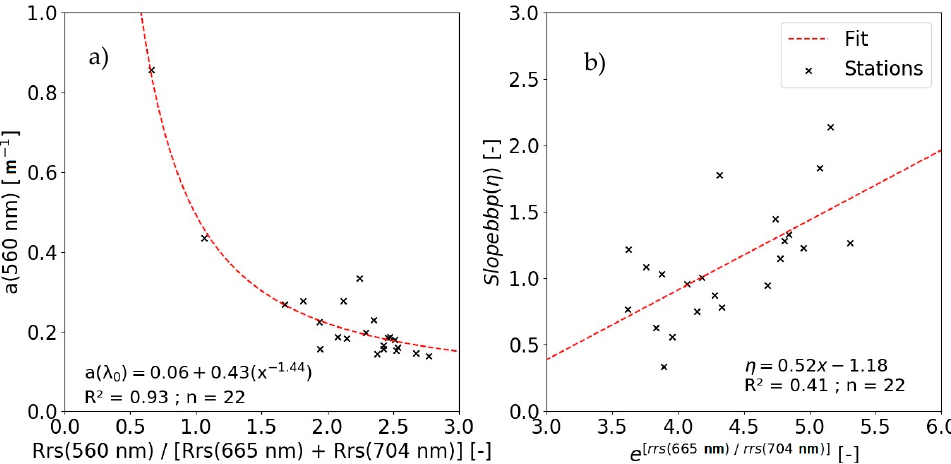
Figure 9. QAA TM reparametrization: ( a ) step 2 exponential adjust; and, ( b ) step 4 linear adjust.